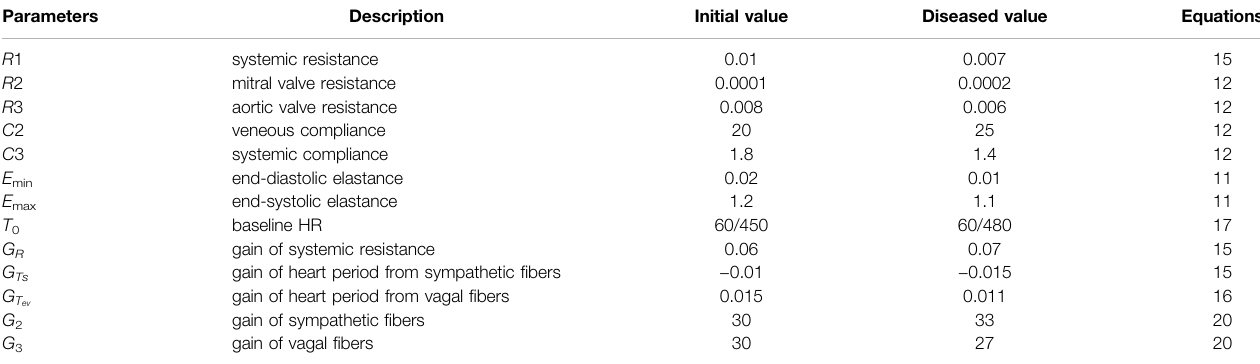
TABLE 2 | Description of the modi fi ed parameters in the in silico physiological model of rat cardiovascular system Yao and Kothare (2020) to construct an overactive sympathetic case.